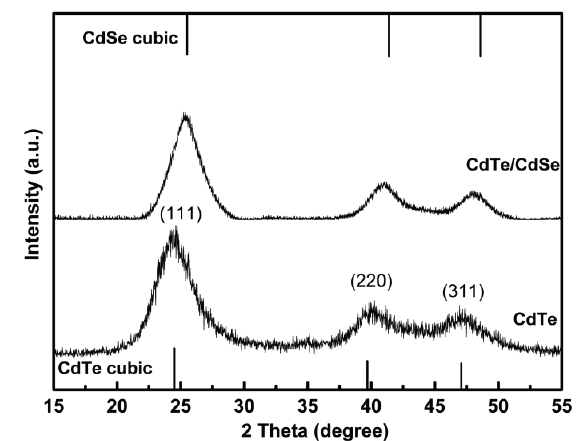
Figure 1. XRD diffraction patterns of CdTe and glutathione (GSH)-CdTe/CdSe quantum dots (QDs) prepared by microwave-assisted method.